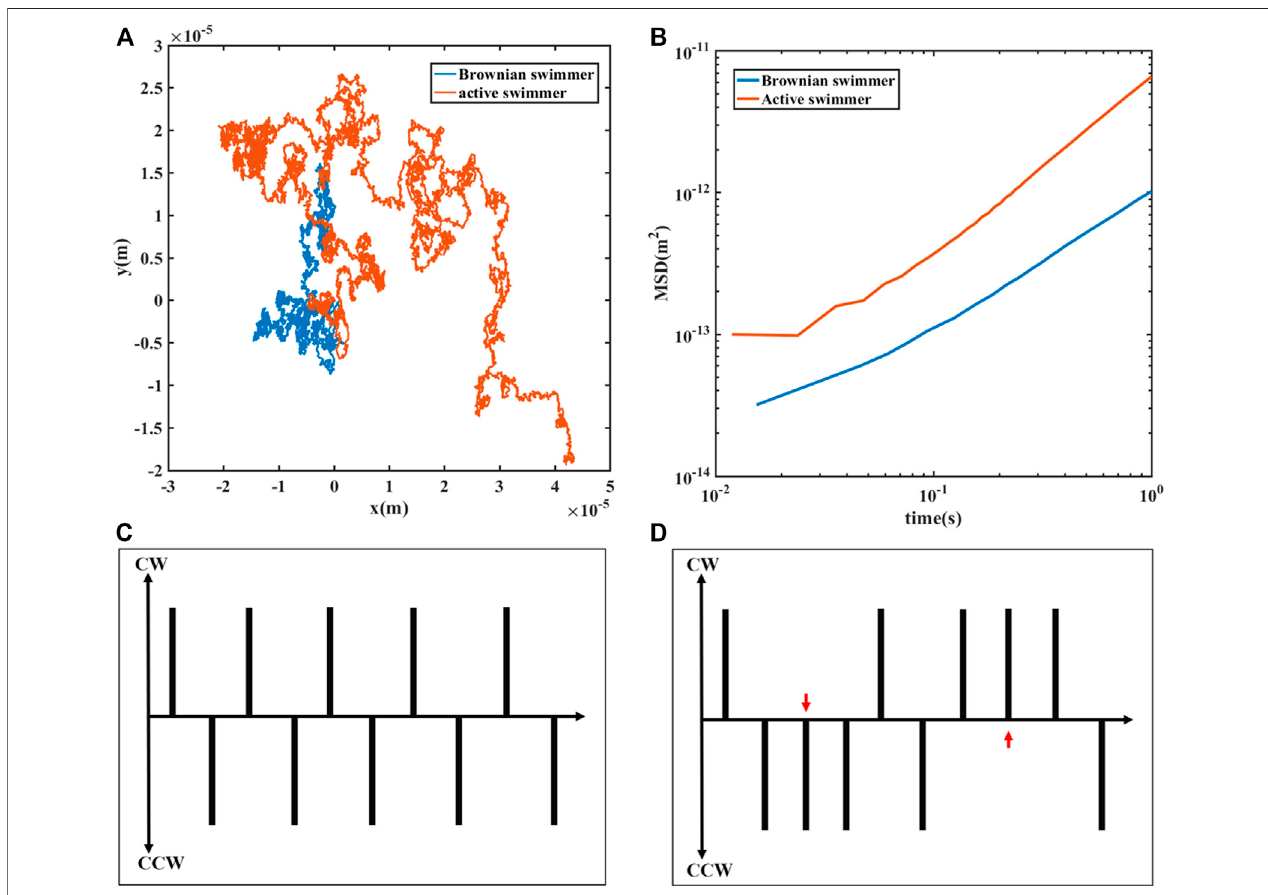
FIGURE2|(A) .Thetypical trajectoryiscomparing theBrownian andanactive propeller.Thepropeller (redcurve)isperforming reciprocalmotionasaresponseto an external fi eld of amplitude 80G and frequency 10 Hz. (B) . Comparison of enhancement in diffusivity for the Brownian and active propeller. (C) . The enhancement of diffusivityiscloselyrelatedtothe ‘ q ’ parameter,whichisaratioofbrokenreciprocity.Thetableshowsaperfectsequenceofclockwise-counterclockwizerotationsabout the long axis of the propeller. (D) . The schematic indicates two instances (red arrows) where the sequence is broken, giving a q value of